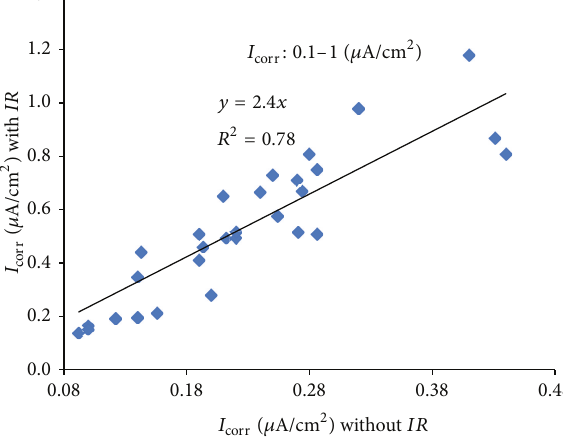
Figure 10: Correlation between 𝐼 < 0.1 𝜇 A/cm 2 . sation for 𝐼 corr